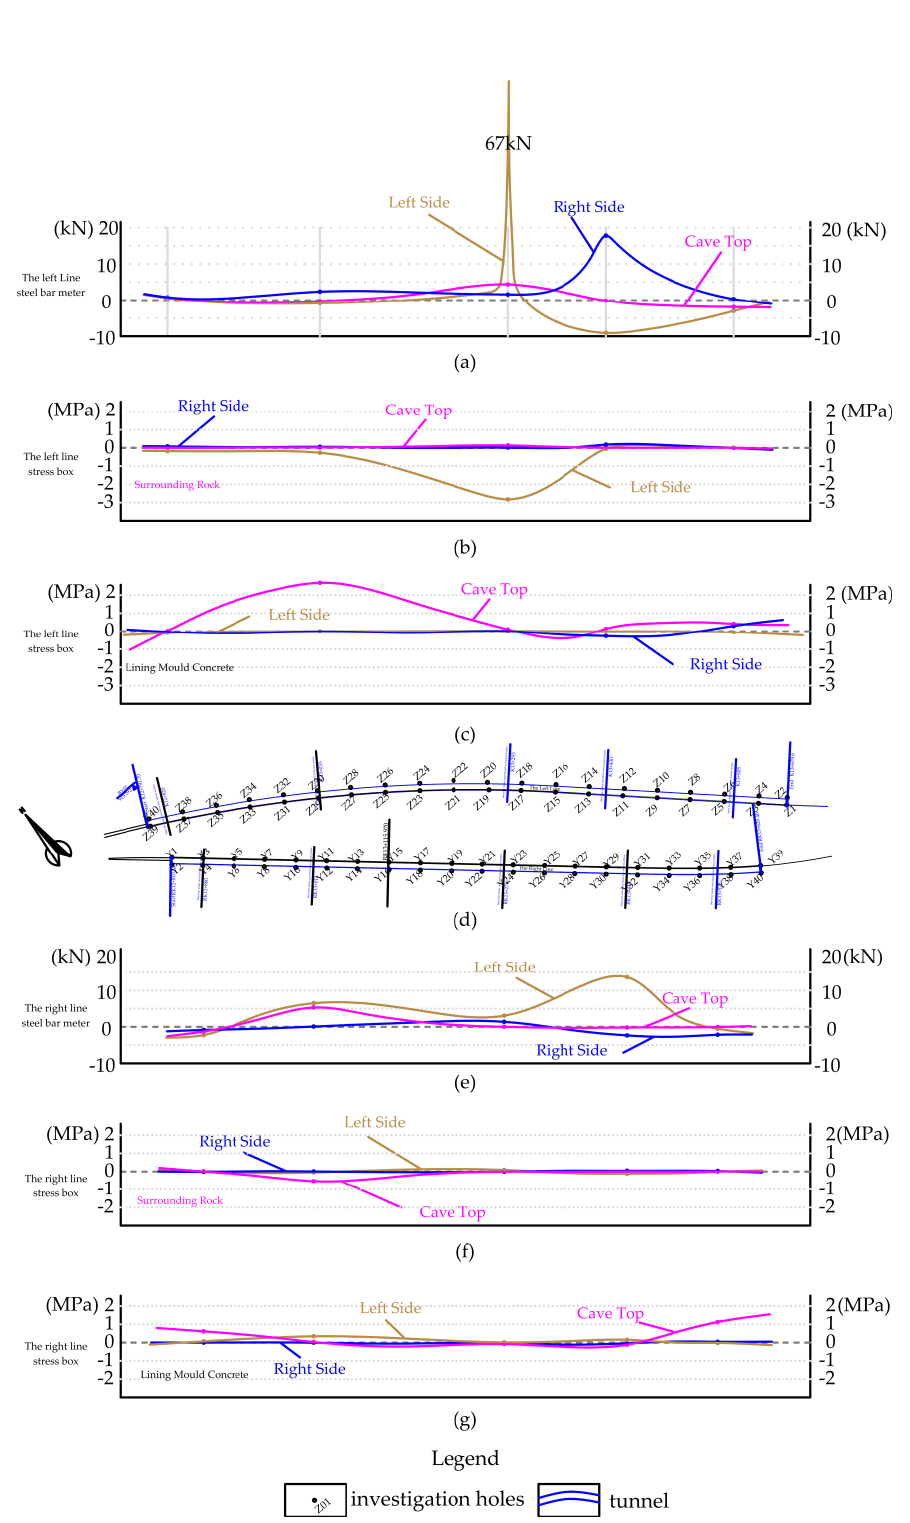
Figure 12. The observation curve of steer bar meters and stress box. (a) Force of the steel bar meter at the left line. (b) Stress of the stress box in surrounding rock at the left line. (c) Stress of the stress box in lining mould concrete at the left line. (d) Plane layout of stress sensors and rebar stress gauges. (e) Force of the steel bar meter at the right line. (f) Force of the stress box in surrounding rock at the right Line. (g) Stress of the stress box in lining mould concrete at the right Line.